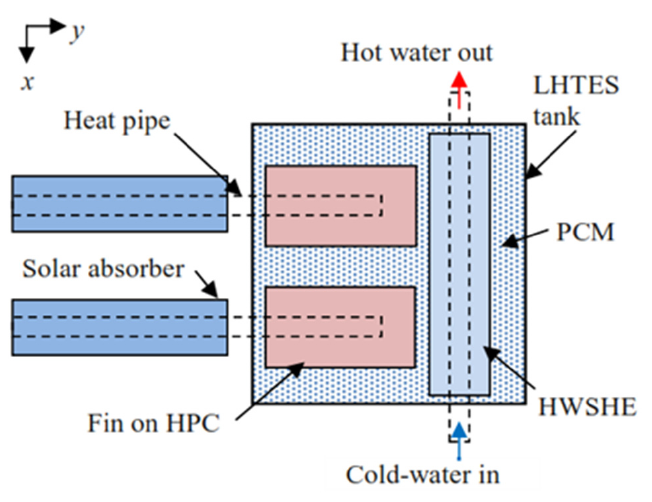
Figure 2. The ETHPSC-assisted LHTES system studied in [14].